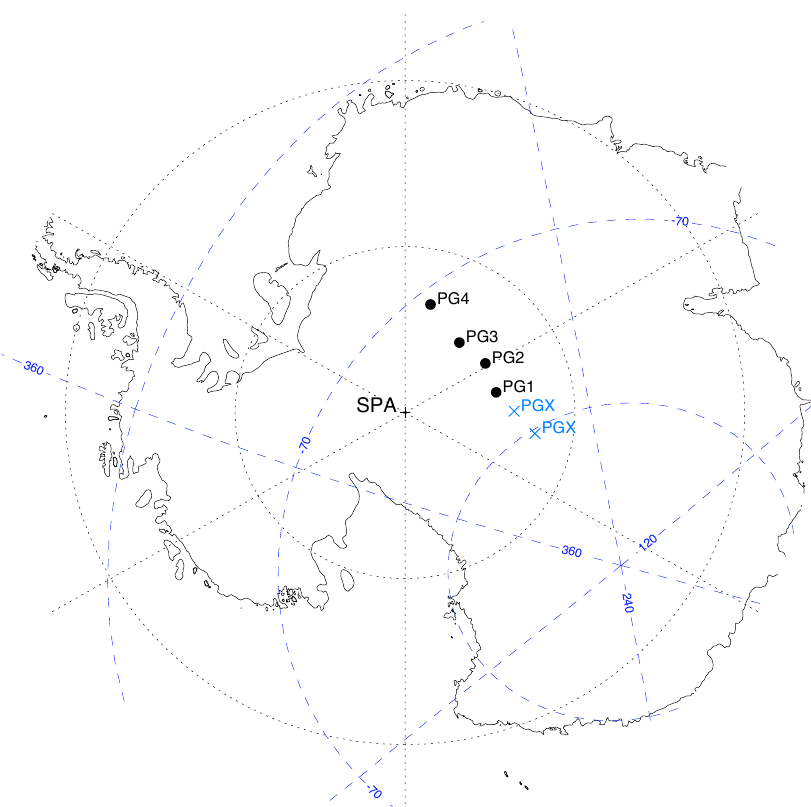
Figure 13. Map showing the locations of the AAL-PIP systems deployed in Antarctica since January